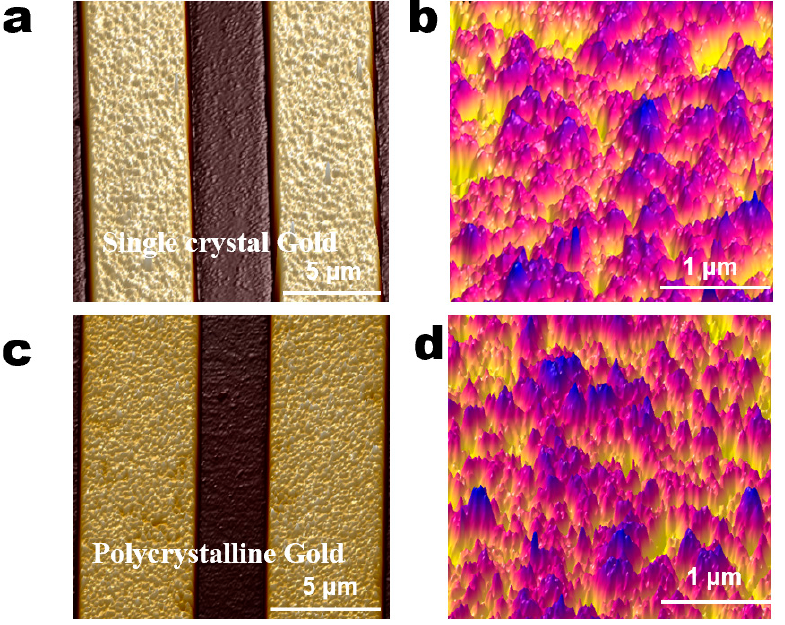
Figure 3. The atomic force microscopy (AFM) images of the single-crystal gold electrode and poly- crystalline gold electrode. ( a ) The single-crystal gold film surface (20 μ m × 20 μ m) was characterized for morphology using AFM; ( b ) surface morphology of single-crystal gold film (3 μ m × 3 μ m); ( c ) polycrystalline gold film surface (20 μ m × 20 μ m) was characterized for morphology using AFM; ( d ) surface morphology of polycrystalline gold film (3 μ m × 3 μ m).